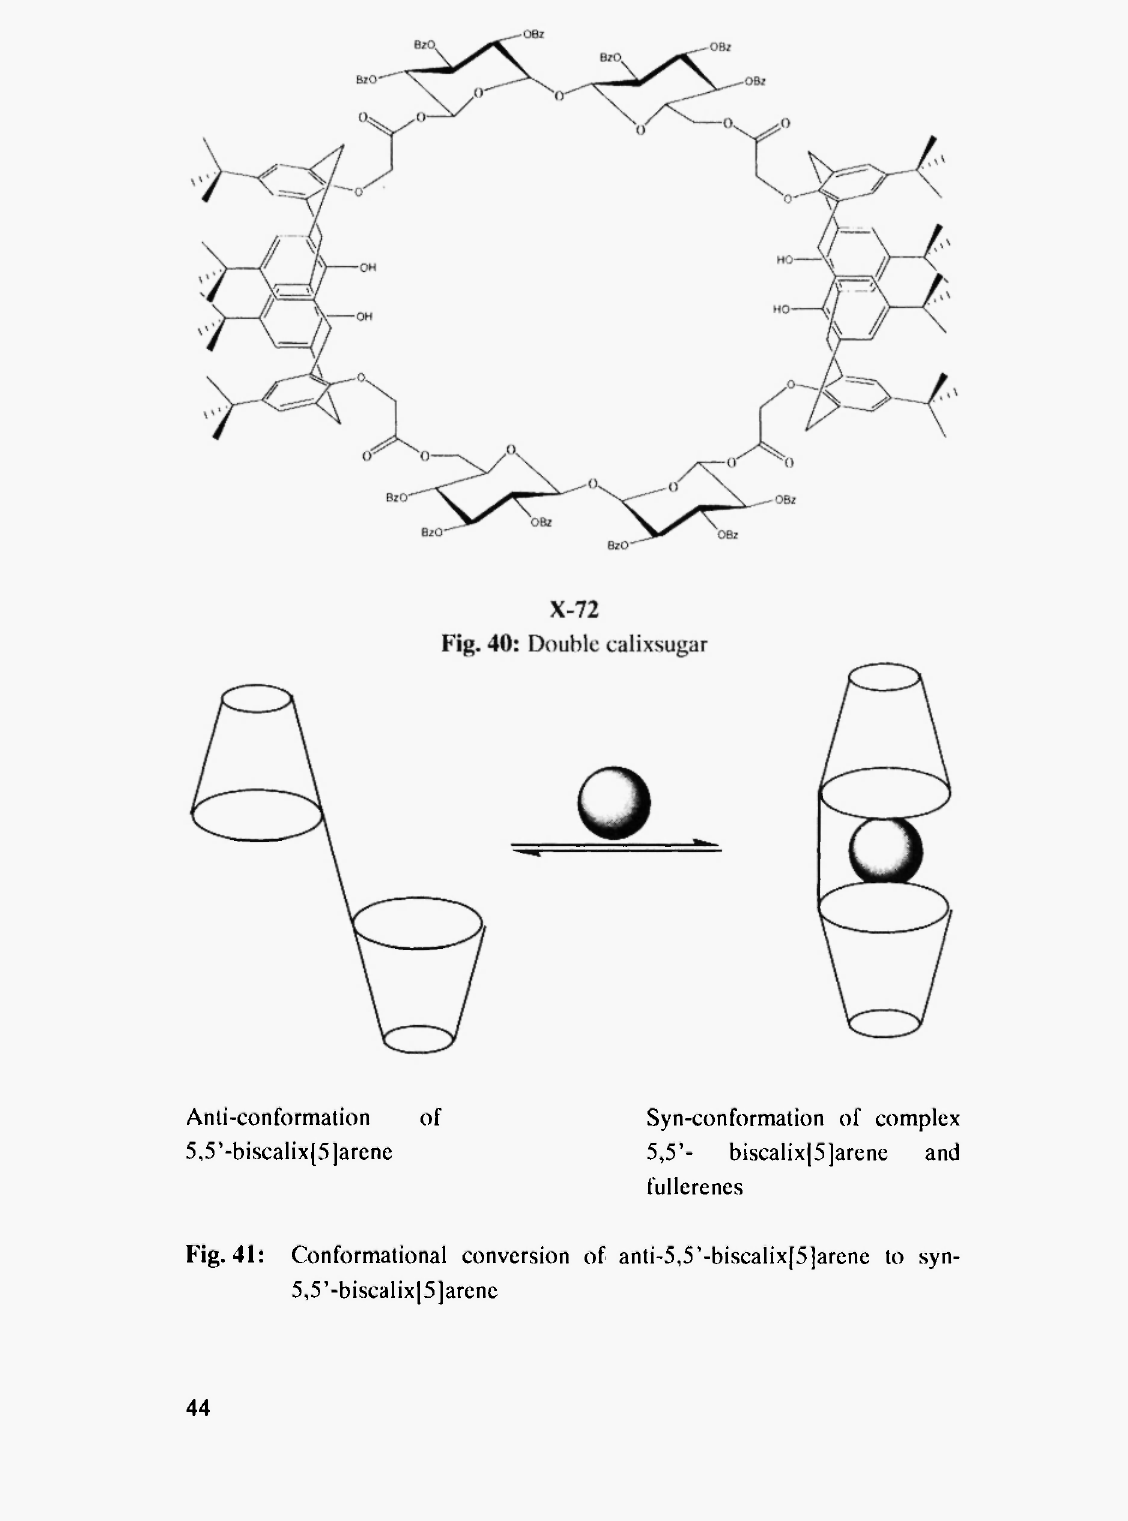
Syn-conformation of complex 5,5'- biscalix(5]arene and fullerenes of anti-S^'-biscalix^Jarene to